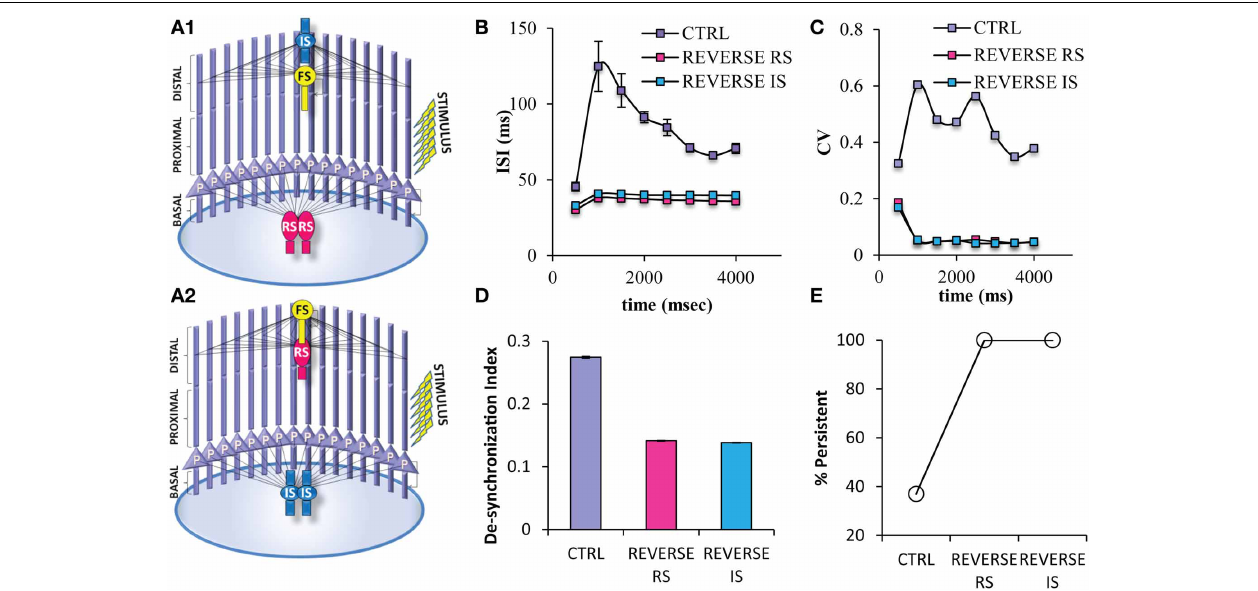
FIGURE 9 | Different variations of the PFC microcircuit were constructed in order to study the effect of the spiking profile of the neuron model that provides somatic inhibition to the pyramidal neuron. (A) Graphical representations of the microcircuit in which 2 RS interneuron models are projecting to the soma, while 1 FS interneuron model projects to the distal dendritic compartment of pyramidal neuron models (Reverse RS) (A1) , and of another microcircuit in which 2 IS interneuron models are projecting to the soma, while 1 FS interneuron model projects to the distal dendritic compartment of pyramidal neuron models (Reverse IS) (A2) . (B) Graph showing ISIs before and during persistent in 500ms bins for the control and the two “reverse” states of the network. The ISIs of pyramidal neuron models are decreased in all